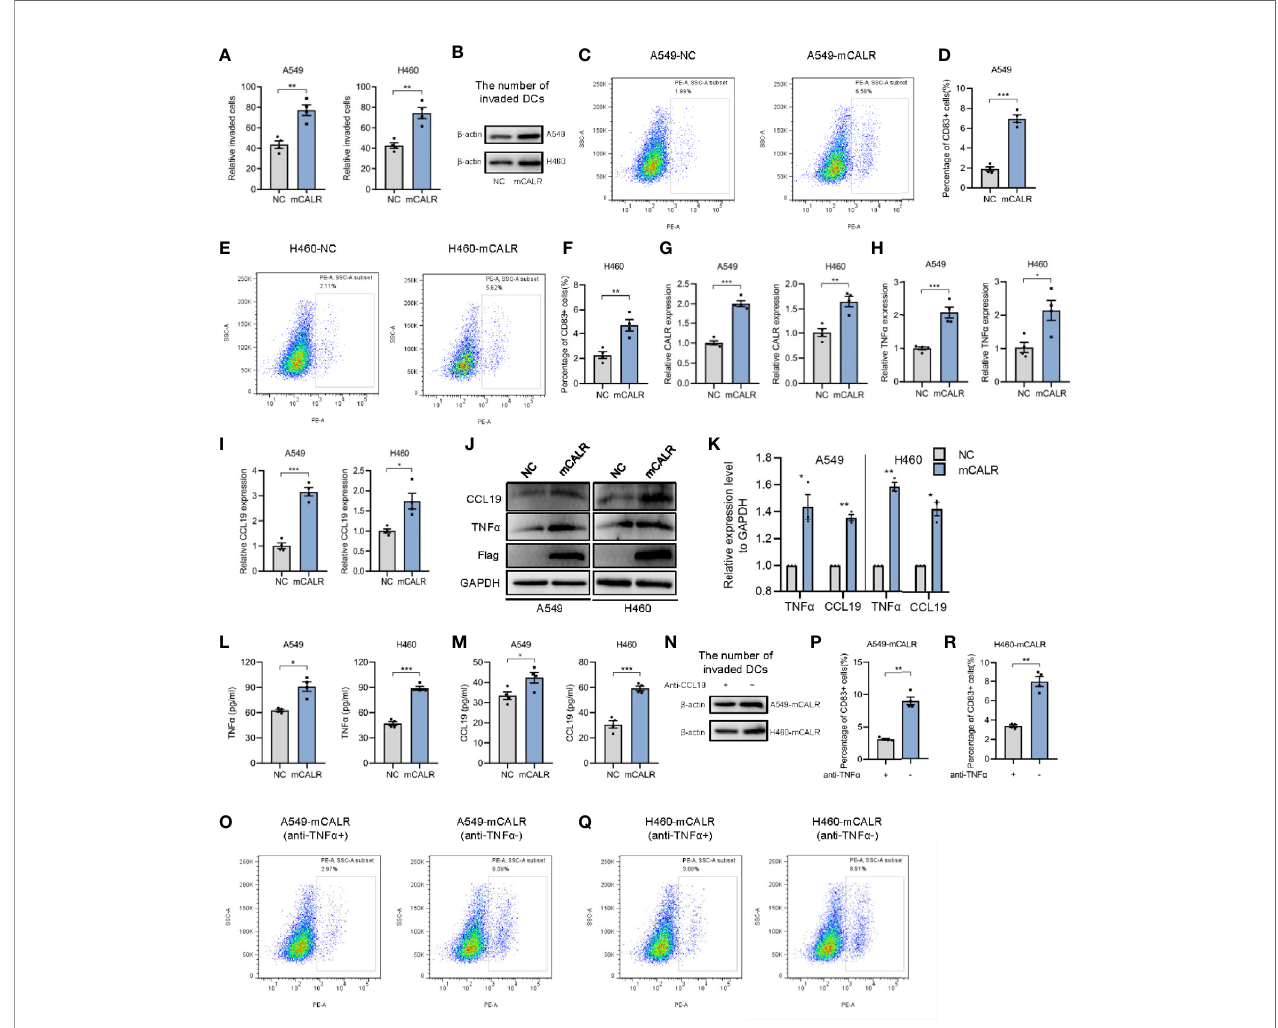
FIGURE 2 | mCALR facilitates the migration and maturation of DCs by increasing the secretion of TNF a and CCL19. (A) The effect of cell supernatants (NC and mCALR) on DC migration was evaluated by migration assay; ** P < 0.01. (B) The number of invaded DCs in both NC and mCALR groups was quanti fi ed by western blot using anti- b -actin antibody. (C – F) The effect of cell supernatants (NC and mCALR) on DC maturation was determined using fl ow cytometry with PE-anti-human CD83 antibody; ** P < 0.01, *** P < 0.001. (G – I) The relative mRNA expression levels of CALR, TNF a , and CCL19 were detected in NC and mCALR groups using real-time PCR; * P < 0.05, ** P < 0.01, *** P < 0.001. (J, K) The expression levels of TNF a and CCL19 were investigated in NC and mCALR groups using western blot; * P < 0.05, ** P < 0.01. (L, M) The expression levels of TNF a and CCL19 were investigated in NC and mCALR groups using ELISA; * P < 0.05, *** P < 0.001. (N) The number of invaded DCs in both anti-CCL19+ and anti-CCL19- groups was quanti fi ed by western blot using anti- b -actin antibody. (O – R) The effect of cell supernatants (anti-TNF a + and anti-TNF a - groups) on DC maturation was determined using fl ow cytometry with PE-anti-human CD83 antibody; **P <